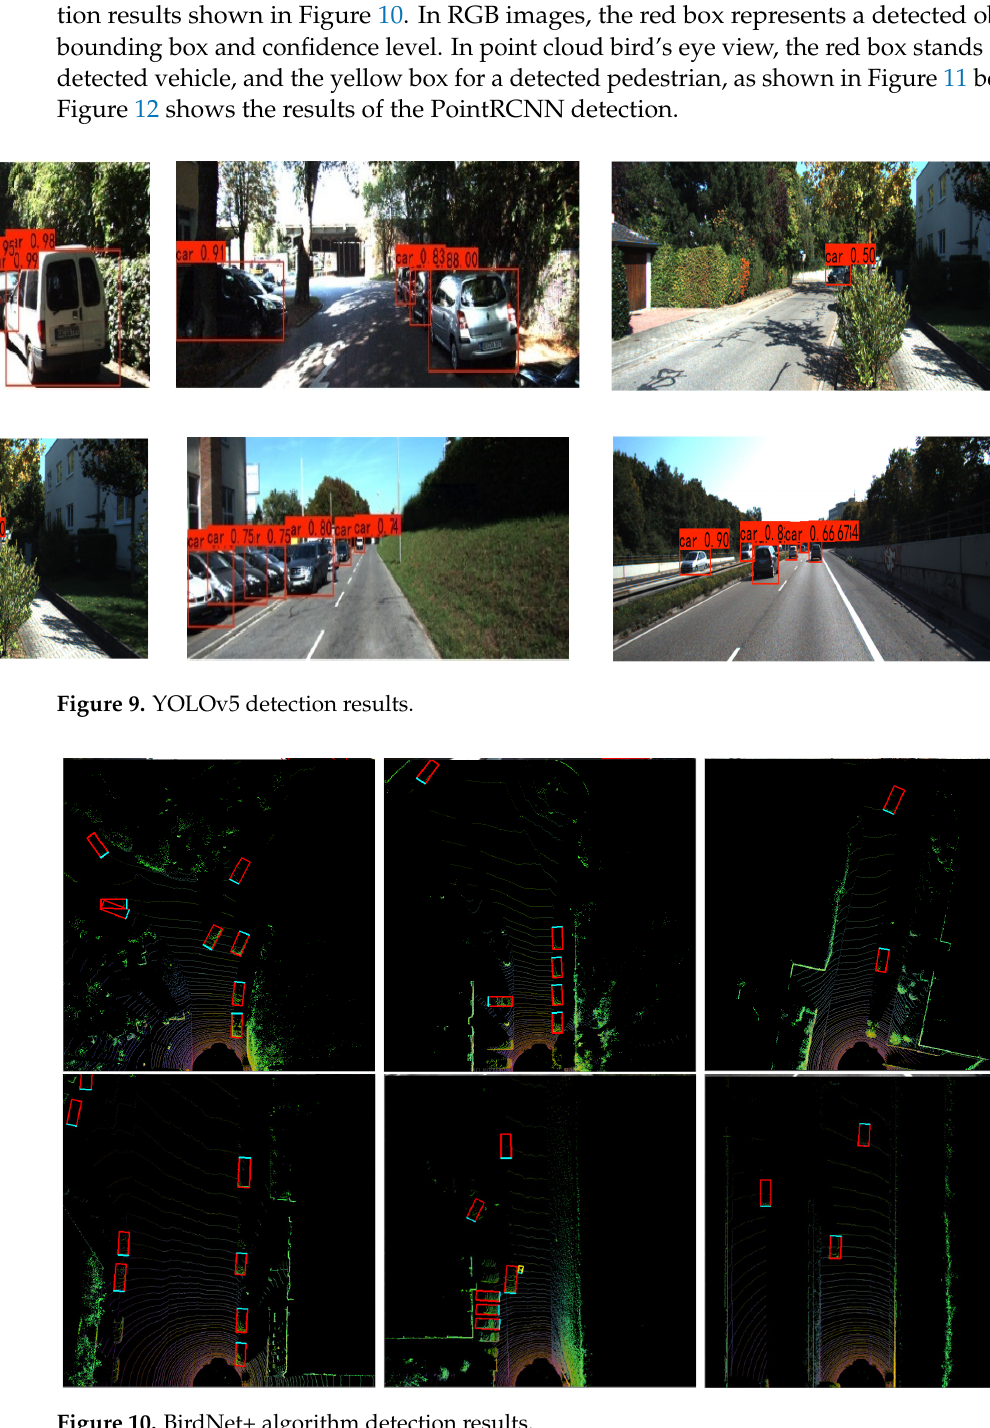
( f ) Figure 11. Comparison of detection results before and after the improvement of the AVOD fusion algorithm. ( a – c ) are the detection results before the improvement and ( d – f ) are the results of the improved algorithm. It can be observed from the above detection results that there are different degrees of missed and false detections in both images and point cloud bird’s eye view detections. The missing and falsehood in image detection more often occur in the case of a vehicle being obscured. The falsehood in point cloud detection is mostly caused by the fact that the shrubs, leaves, and other objects on both sides of the road, which are similar in shape to the point cloud of vehicles and pedestrians, are detected as vehicles.